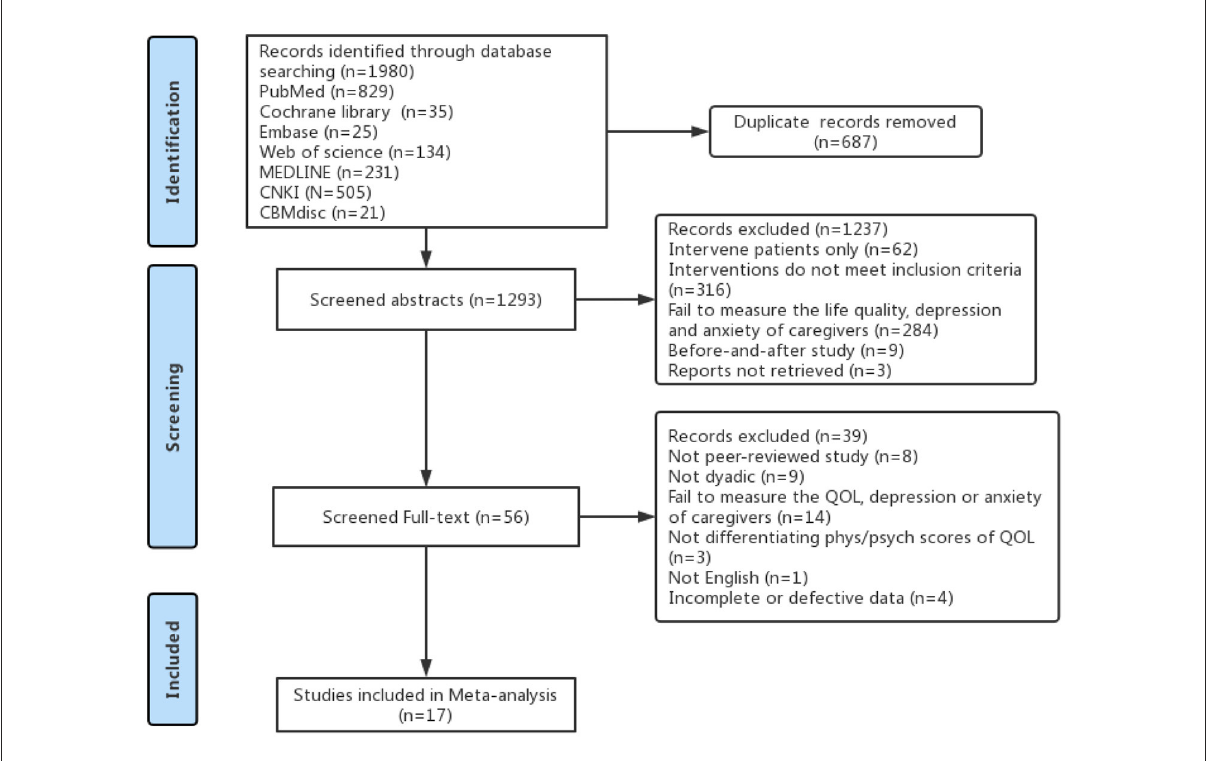
FIGURE1 PRISMA flow diagram of the study selection